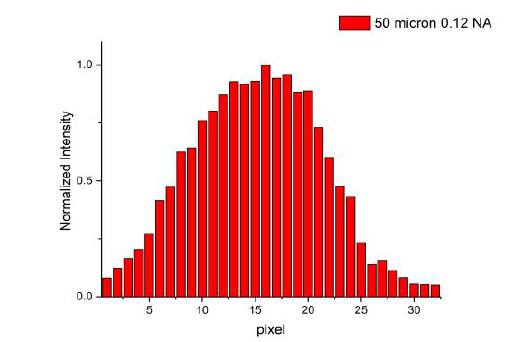
Fig. 3. The illumination function of system using the uniformly circular aperture from 50 µ m 0.12